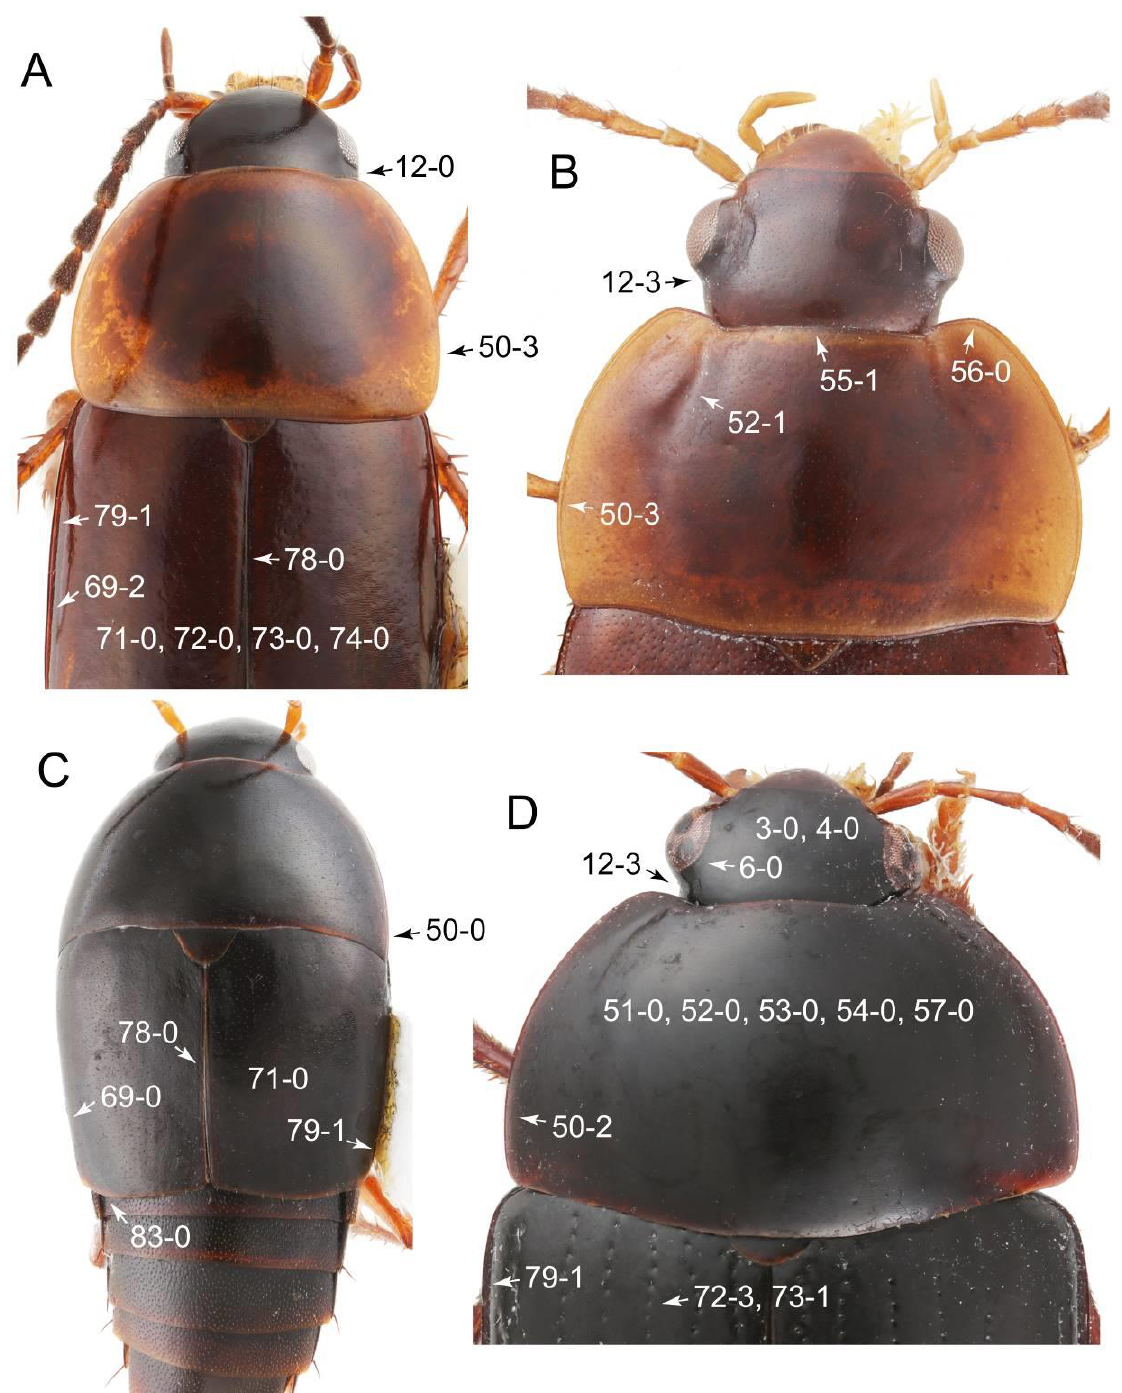
Figure 51. Photographs of body parts of Tachinusini, enlarged, dorsal view. ( A ) forebody of Nitidotachinus tachyporoides . ( B ) head and pronotum of Pseudotachinus besucheti . ( C ) forebody and part of abdomen of Tachinomorphus grossulus . ( D ) forebody of Olophrinus cf. philippinus . Characters and character states (format X-X) are indicated on each